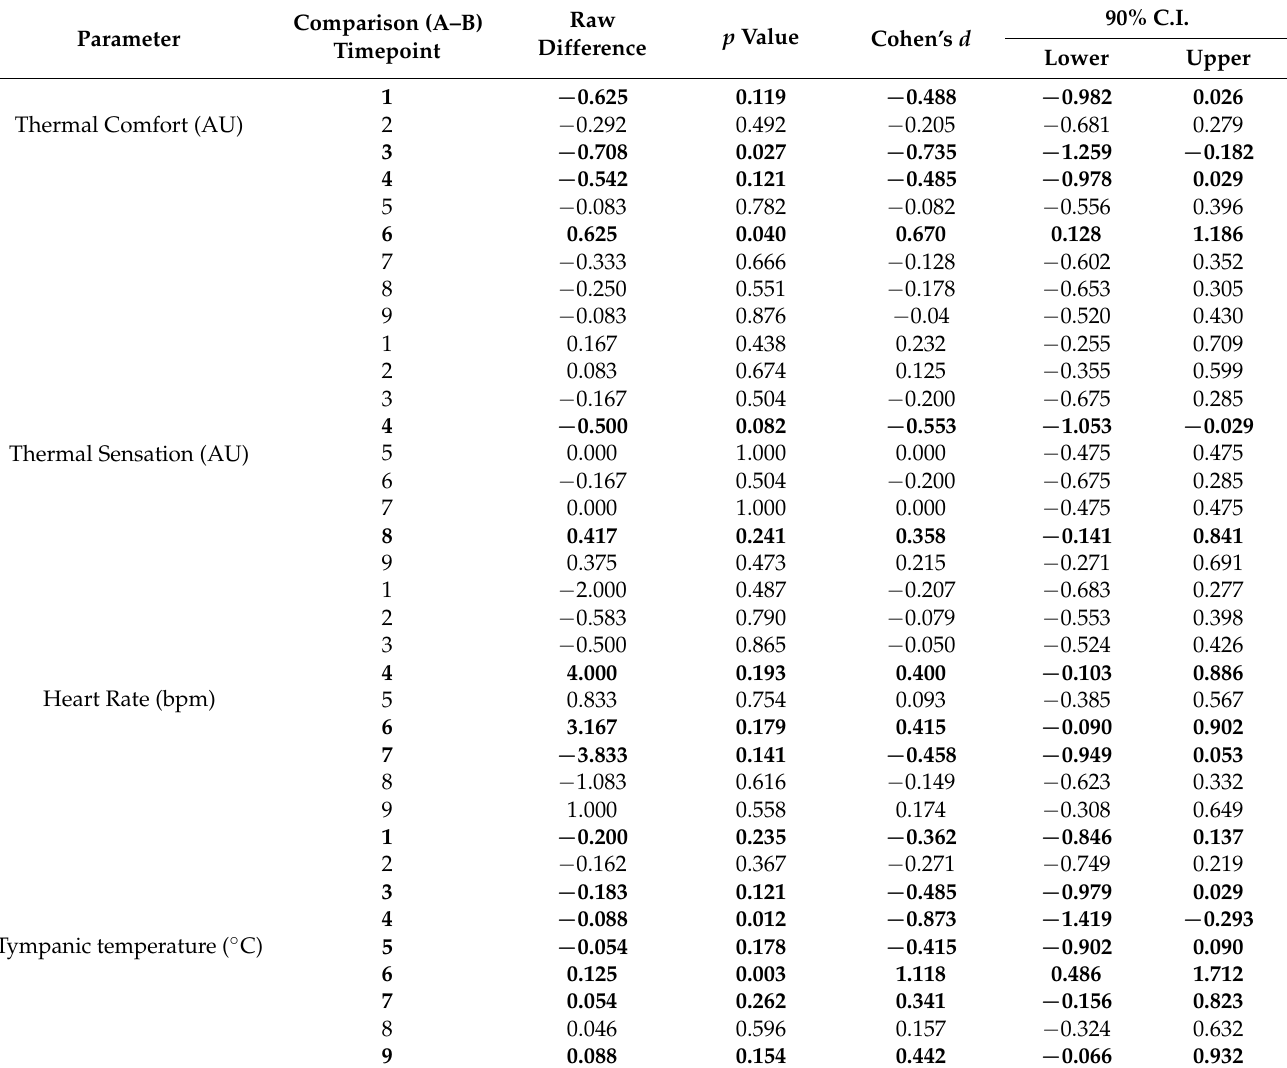
Table 2. Between solution differences at matched time points, including statistical significance, estimates of magnitude and uncertainty 1